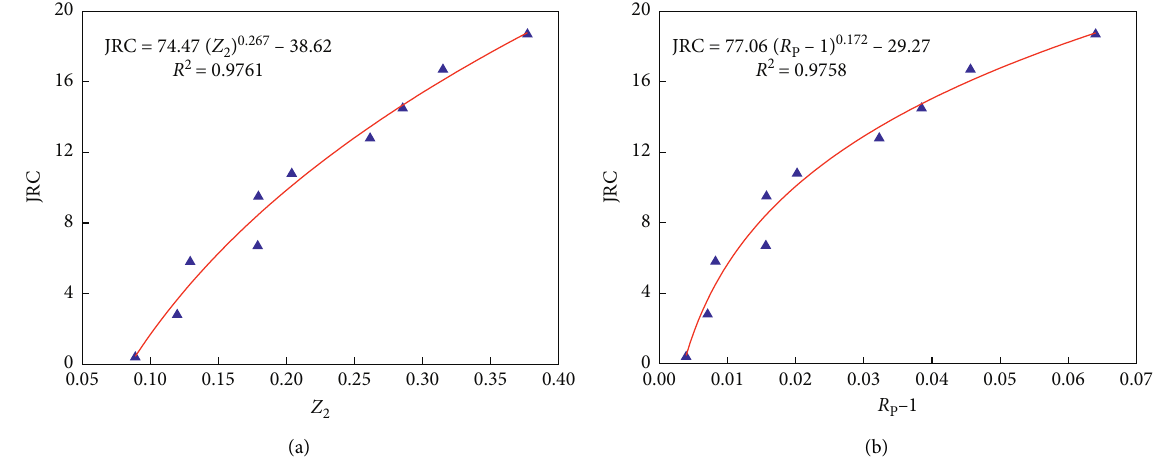
JRC = 74.47 ( Z ) 0.267 – 38.62 2 R 2 = 0.9761